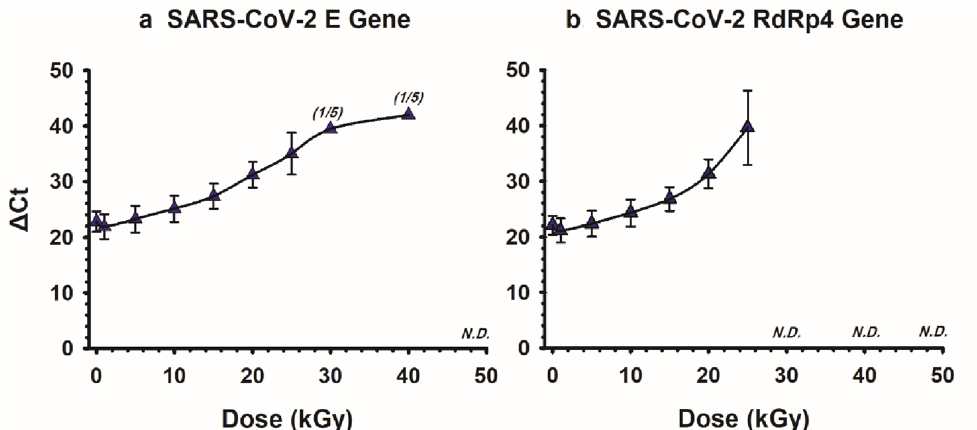
Figure 5. Delta Ct values of SARS-CoV-2 RNA samples irradiated with gamma irradiation. Five samples were treated with 1, 5, 10, 15, 20, 25, 30, 40 and 50 kGy. Detection of SARS-CoV-2 RNA was performed using RT-qPCR based on both E ( a ) and RdRp4 genes ( b ). Statistically, both genes showed an overall significant ( P < 0.001) increase in ΔCt values with increased doses of gamma radiation. Pairwise comparison for E gene (0 kGy vs. 15, 20, 25, 30 and 40 kGy) were significant ( P < 0.001). Pairwise comparison for RdRp4 gene (0 kGy vs. 20 and 25 kGy) were significant ( P < 0.001). 1/5: one sample out of 5 was detected. N.D.: not detected. Symbols represent the mean and error bars indicate the standard deviation.